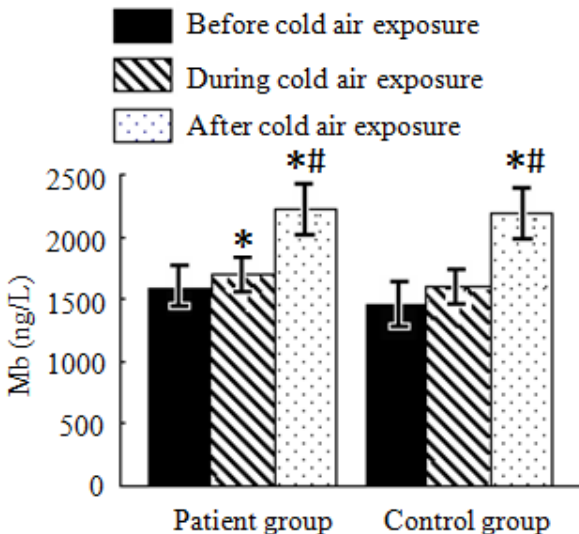
Figure 1. Average Mb levels in the patient and control groups during a cold air event.